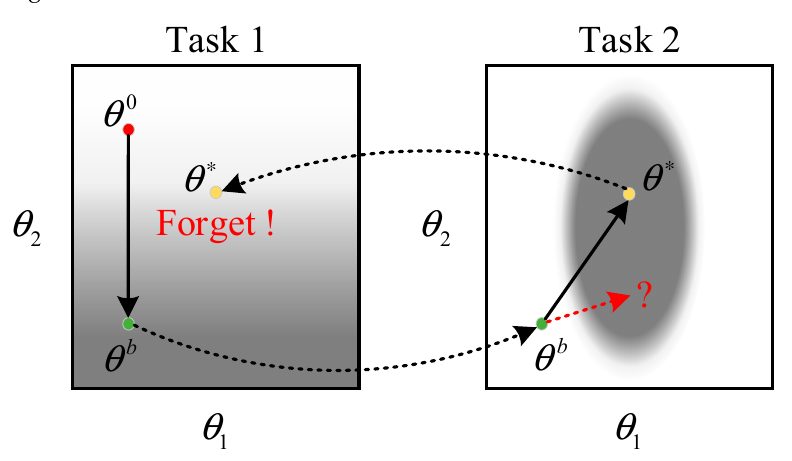
Figure 4. The error surfaces in tasks 1 and 2.